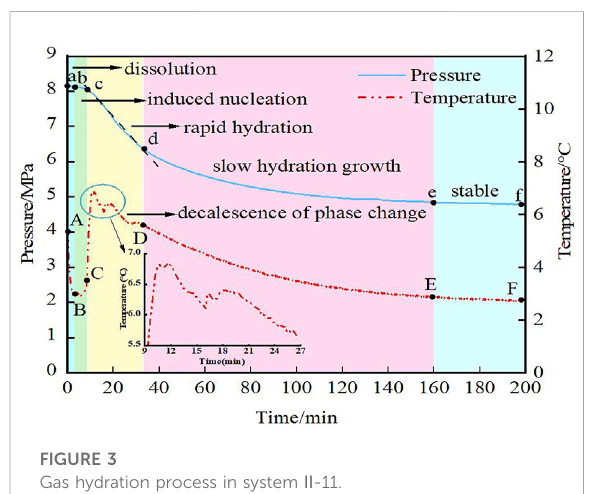
FIGURE 3 Gas hydration process in system Ⅱ